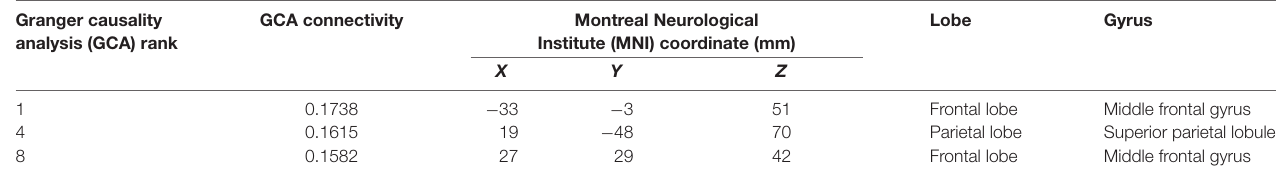
TABLE 1 | Information on the three stimulation targets selected with cortico-hippocampal brain connectivity. Granger causality GCA